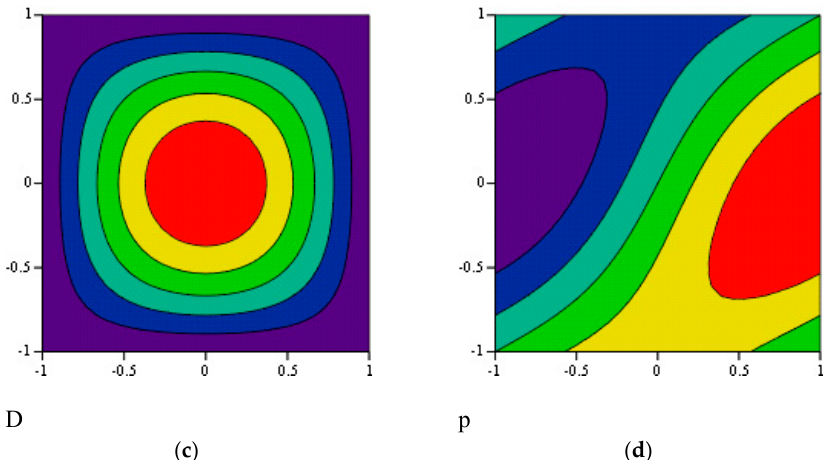
Figure 3. The calculated fields of vorticity ( a ), temperature ( b ), divergence ( c ), and pressure ( d ) in = lower part of the vortex cell (at 0 5 z . ).